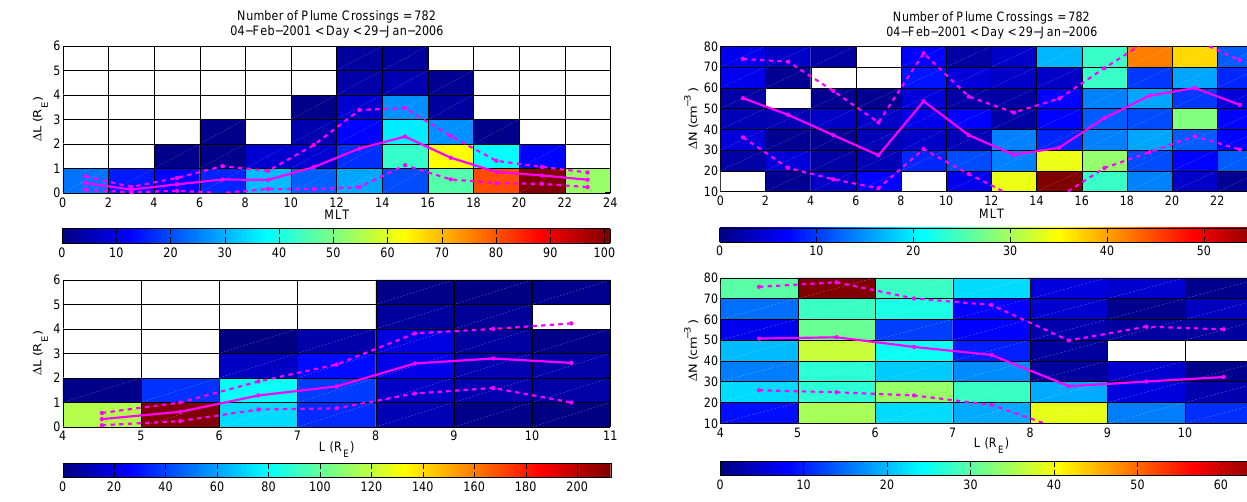
Fig. 12. Distribution of plasmaspheric plumes observed by WHIS- PER onboard Cluster during the five years of data analysed. The width 1L of the plume is shown as a function of MLT in the top panel, and as a function of L in the bottom panel. The color code gives the number of events in each bin. The solid magenta curves give the mean 1L value inside each MLT range in the top panel, and inside each L range in the bottom panel, and the two dashed magenta curves the standard deviations of those values.